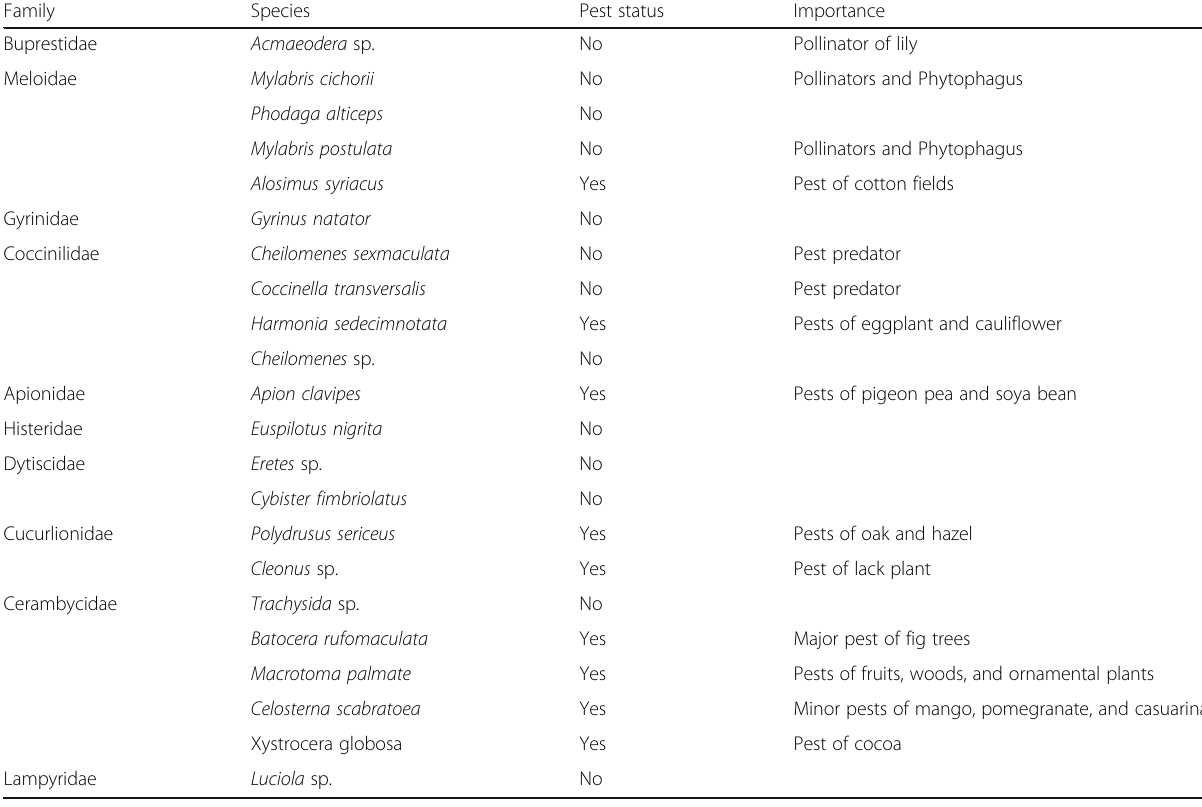
Table 1 Annotated checklist and pest status of Coleoptera of Vadodara, Gujarat, India (Continued)